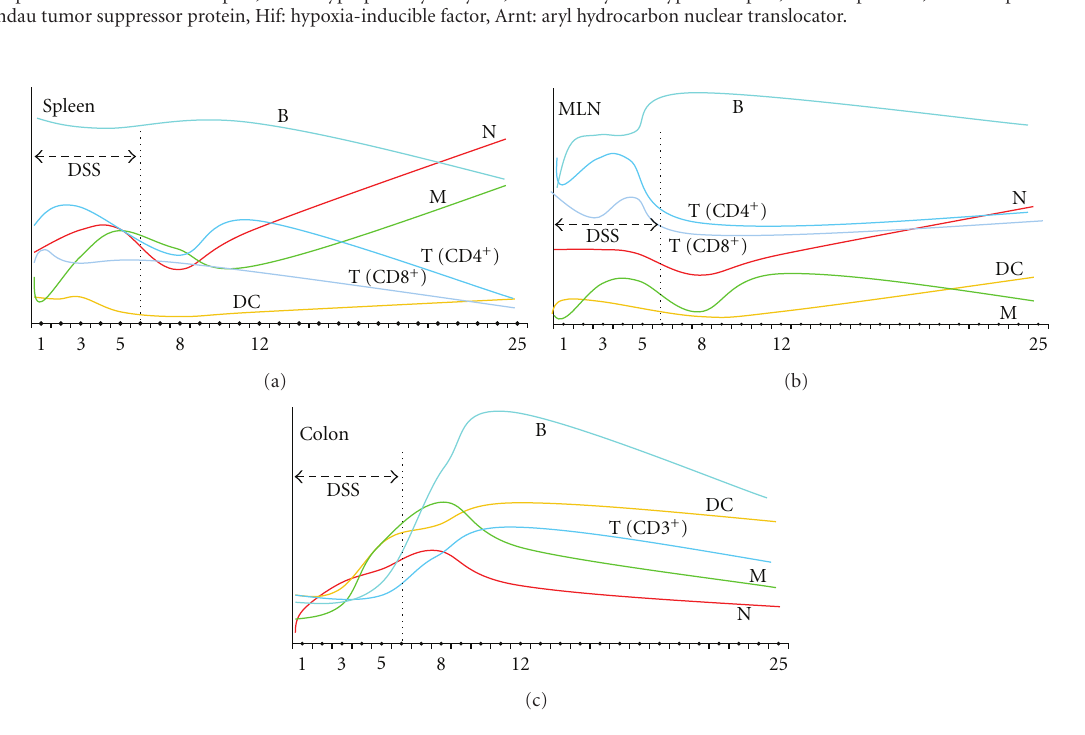
Figure 8: Schematic representation of mucosal (colon) and systemic (spleen, MLN) immune responses in C57BL/6OlaHsd mice exposed to 3% DSS for 6 days followed by water for 19 days. Measurements were made on day 0, 1, 3, 5, 8, 12, and 25 as denoted by numbers. Schematic representation is based on results obtained by Hall et al. [23]. MLN: mesenteric lymph nodes, N: neutrophils, M: